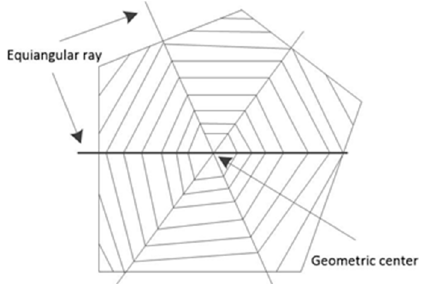
Figure 4. Schematic diagram of spiral fill scanning.